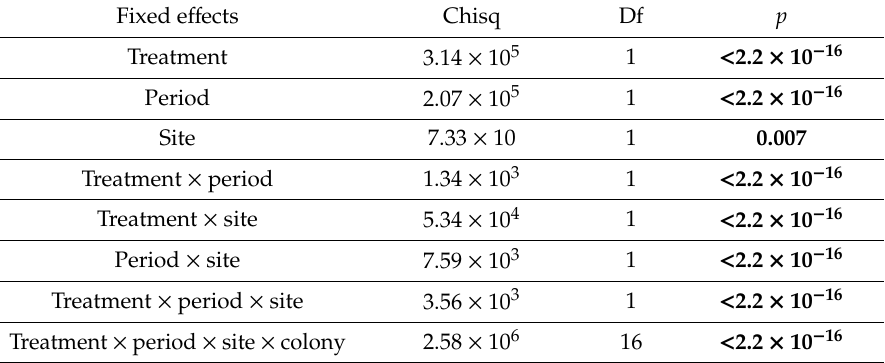
Table 2. Results from generalized linear mixed model analysis for changes in endosymbiont density in response to individual factors (treatment, period, site, colony) and interaction between these factors. Significant values are in bold.